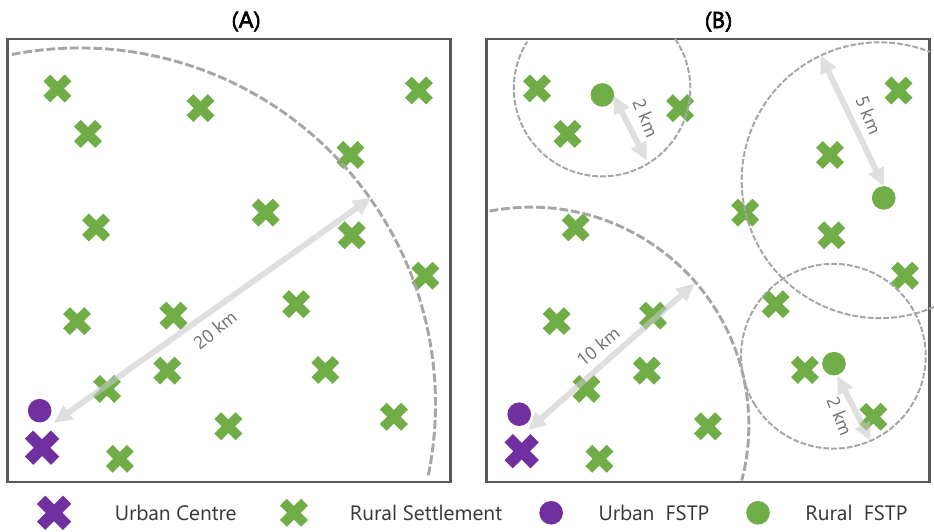
Figure 8. Two representative clustering regimes: ( A ) all gram panchayats within 20 km of a city or town clustered together for urban–rural partnership ( B ) smaller groups of gram panchayats clustered for urban–rural and rural–rural